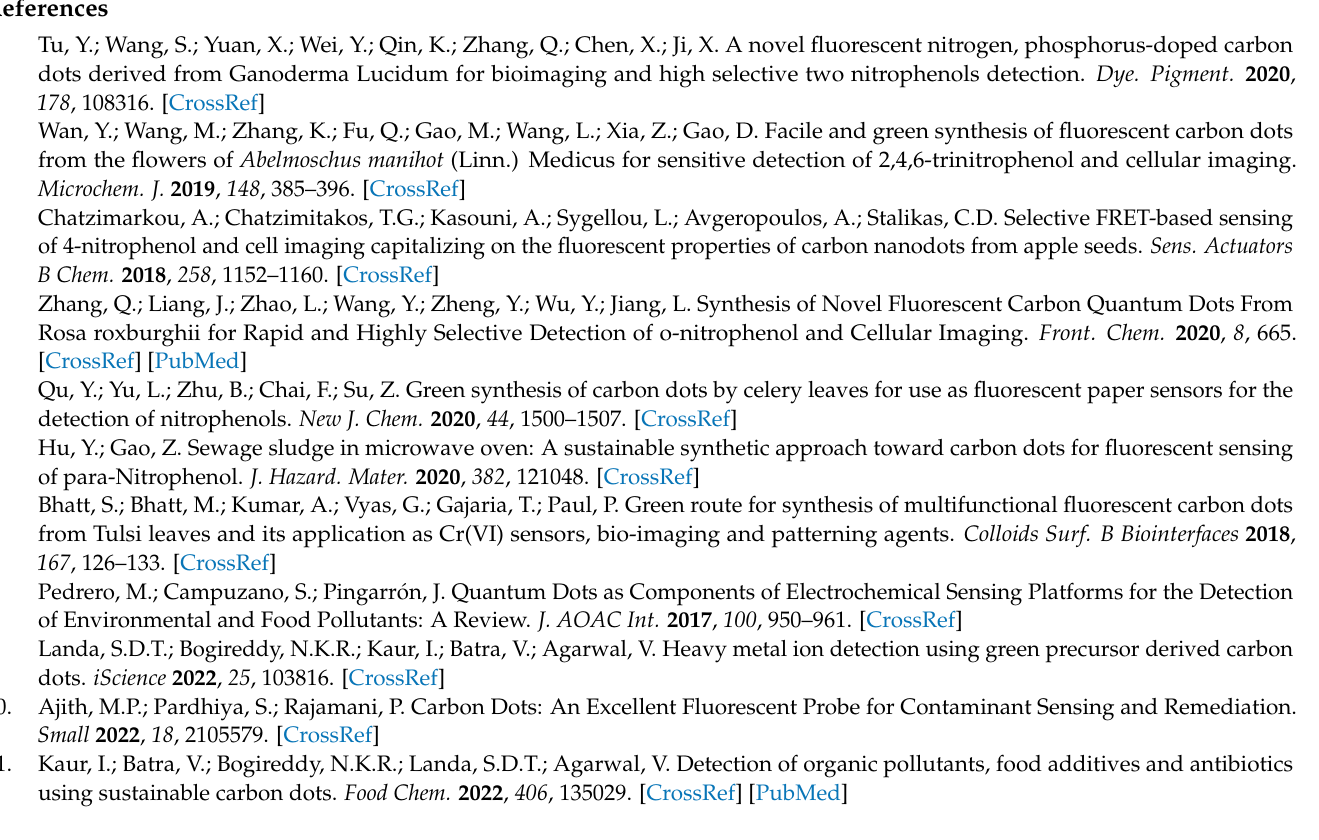
Table S2: Detection of Cr(VI) using CDs derived from